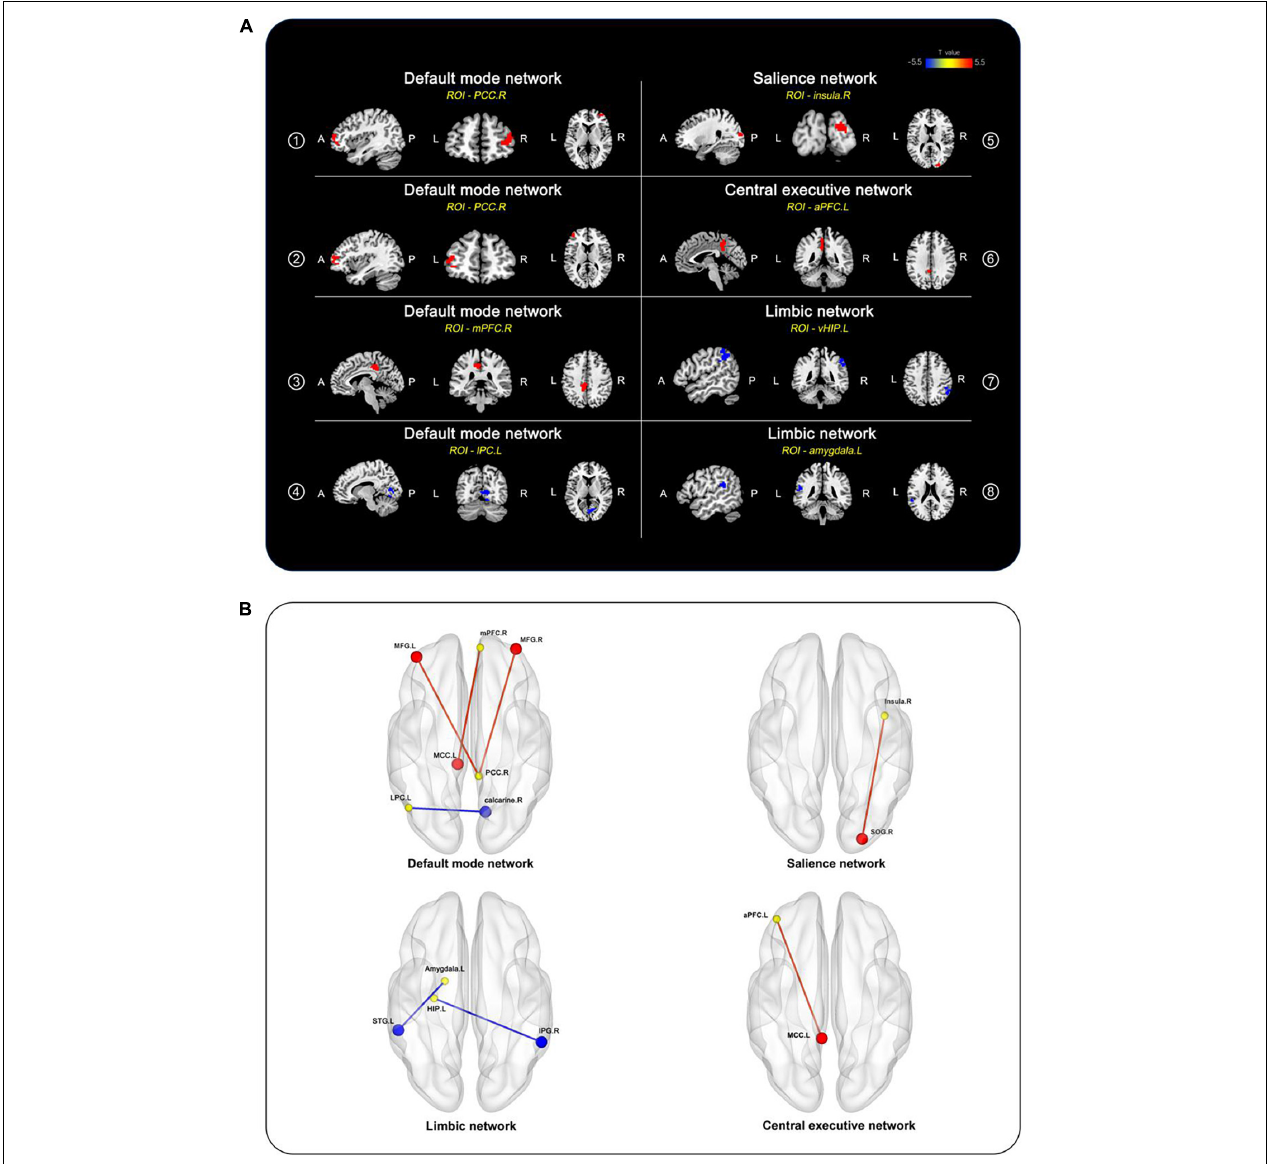
FIGURE 1 | Brain regions of between-group differences in FC after adjusting for age, sex, and education duration (cluster P < 0.05, FDR-corrected). (A) Compared to the non-DNR group, the DNR group exhibited aberrant connectivity to the whole brain in seven ROIs, including the right PCC, right mPFC, and left lateral parietal cortex located in the DMN; the right insula located in the SN; the left anterior prefrontal cortex in the CEN; the left ventral hippocampus and left amygdala in the limbic network. The color scale denotes the T values. (B) 3D view of the brain. The yellow nodes represent the ROIs in the DMN, SN, CEN, and limbic network. The red/blue nodes and edges represent the brain regions with increased/decreased FC to the ROIs in the DNR patients compared to the non-DNR patients. aPFC, anterior prefrontal cortex; CEN, central executive network; DMN, default mode network; DNR, delayed neurocognitive recovery; FC, functional connectivity; FDR, false discovery rate; vHIP, ventral hippocampus; IPG, inferior parietal gyrus; LPC, lateral parietal cortex; MCC, middle cingulate cortex; MFG, middle frontal gyrus; mPFC, medial prefrontal cortex; PCC, posterior cingulate cortex; ROIs, regions of interest; SN, salience network; SOG, superior occipital gyrus; STG, superior temporal gyrus; A, anterior; P, posterior; L, left; R, right.